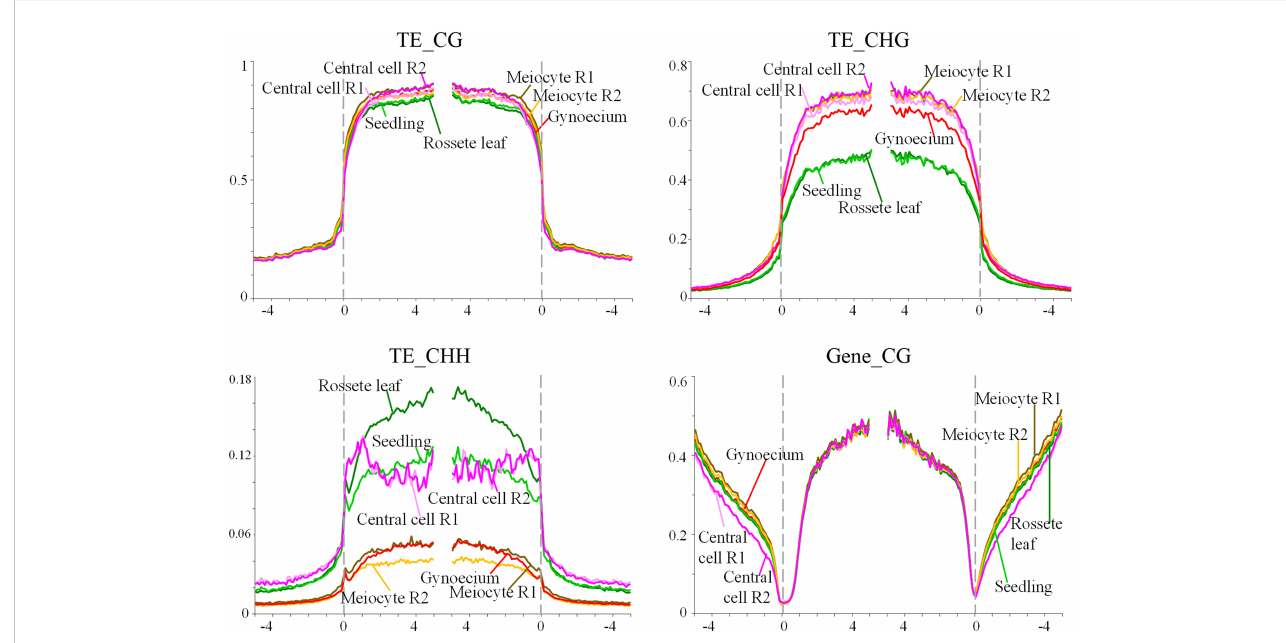
FIGURE 1 Methylation levels of TEs and genes in the CHH and CG contexts. The graph shows the methylation frequency shown at each nucleotide position for alignments in all three contexts (TEs), or the CG context (genes); rosette leaf (dark green), seedling (light green), central cell replicate #1 (Central cell R1) (light pink), central cell replicate #2 (Central cell R2) (dark pink), male meiocyte replicate #1 (Meiocyte R1) (brown), male meiocyte replicate #2 (Meiocyte R2) (yellow), wild-type gynoecium